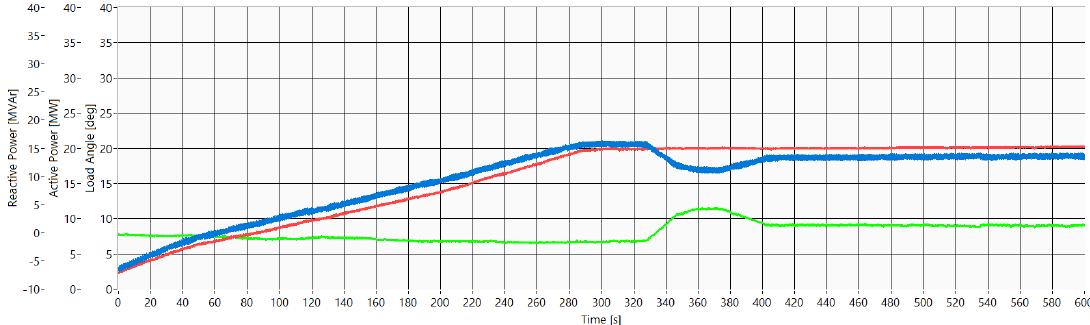
Figure 18. Testing results of the load angle measurement algorithm of the synchronous generator under a change in first the active and then the reactive power. The red curve represents the active power measurements, the green curve represents the reactive power measurements and the blue curve the load angle measurements.